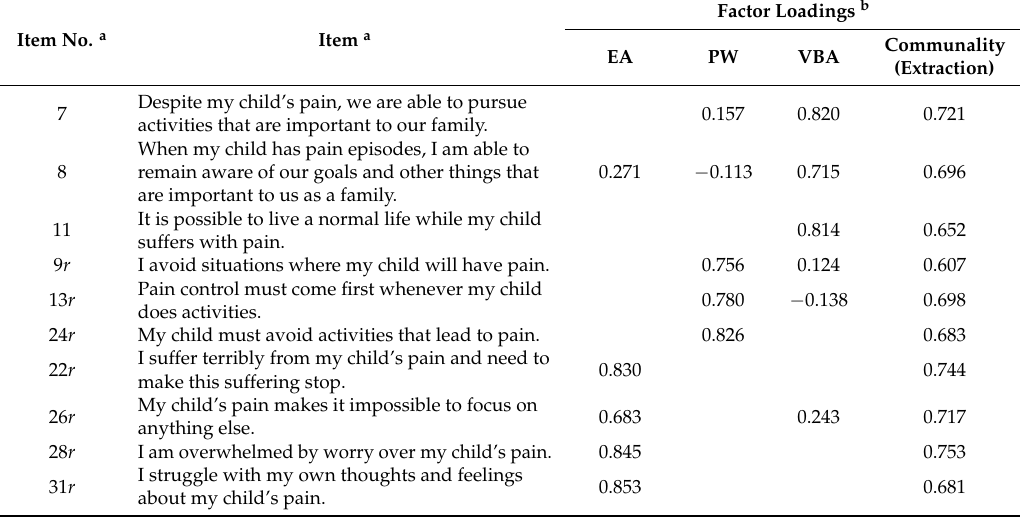
Table 1. Factor loadings and communalities, based on a principle components analysis (PCA) with oblimin rotation, for 10 items from the 17-item version of The Parent Psychological Flexibility Questionnaire (PPFQ-17; n =